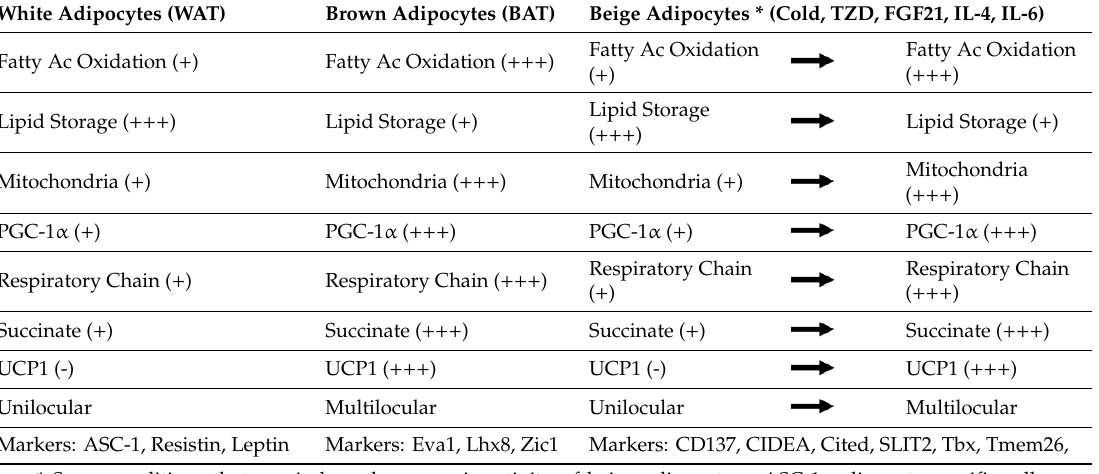
Table 1. Characteristics of different adipocyte